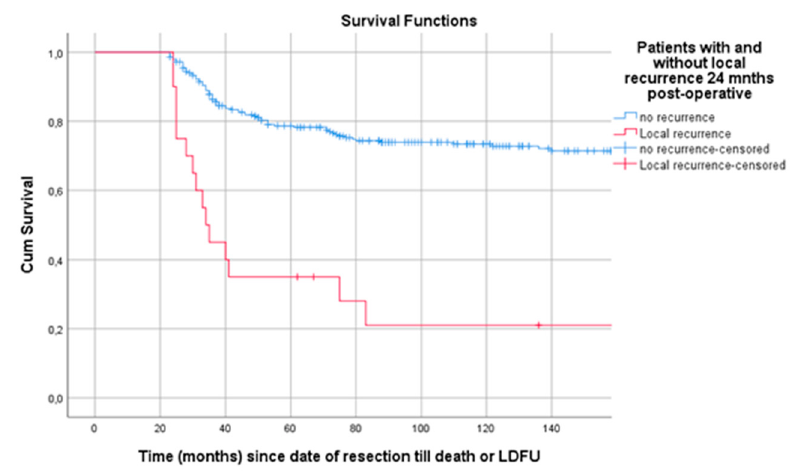
Figure 6. Landmark analysis of patients with and without LR 24 months post-surgery. Legend: LR = local recurrence, cum survival = cumulative survival, LDFU = last date of follow-up.